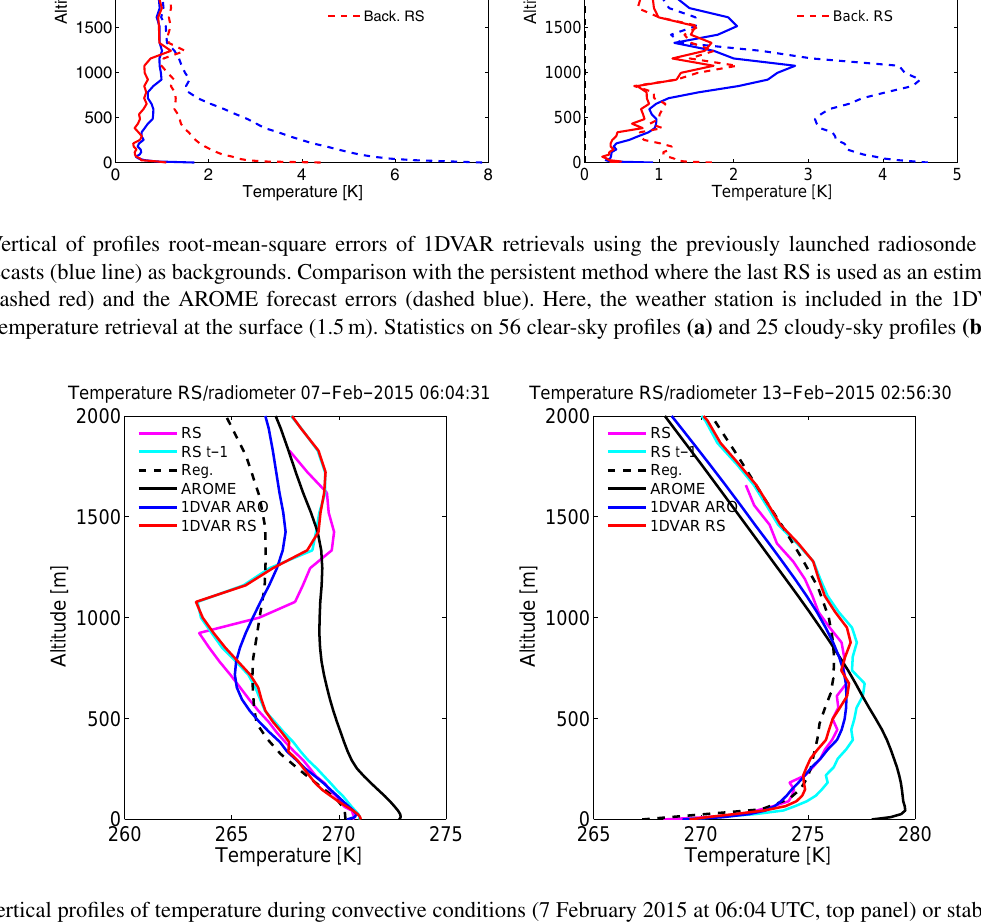
Figure 14. Vertical profiles of temperature during convective conditions (7 February 2015 at 06:04UTC, top panel) or stable conditions (13 February at 02:56UTC). Comparison between radiosonde profile (magenta), linear regression (dashed black line) and 1DVAR from AROME forecasts (blue), 1DVAR from previous radiosonde (red). Background profiles corresponding to either the 1h AROME forecast (black) or the previously launched radiosonde (cyan) are also